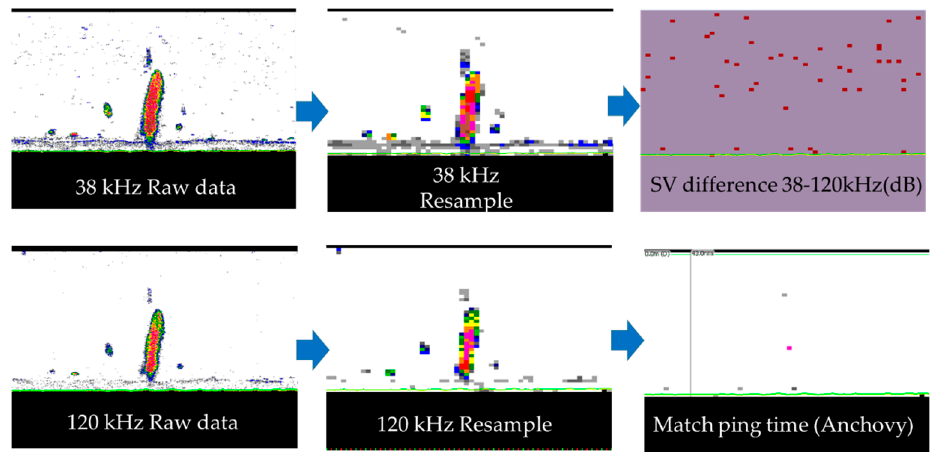
Figure 4. Anchovy identification